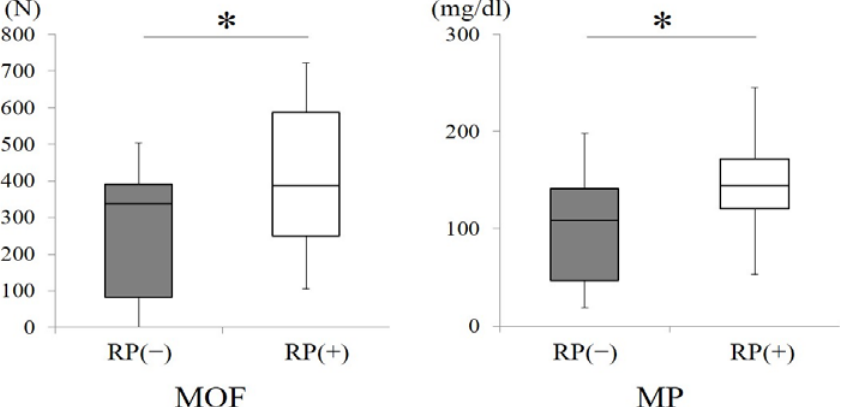
Figure 5. Comparisons of maximum occlusal force and masticatory performance between all subjects with and without removable prostheses. (* p < 0.01, Wilcoxon signed-rank test) RP ( − )): subjects without removable prostheses; RP (+): subjects with removable prostheses.